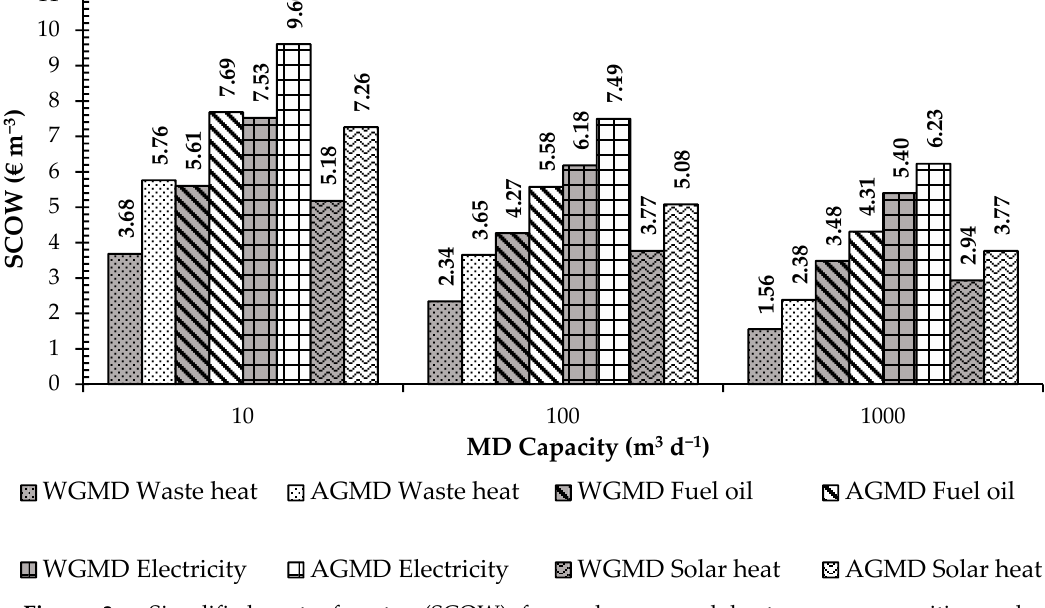
Figure 3. Simplified cost of water (SCOW) for each proposed heat source, capacities and MD configurations.